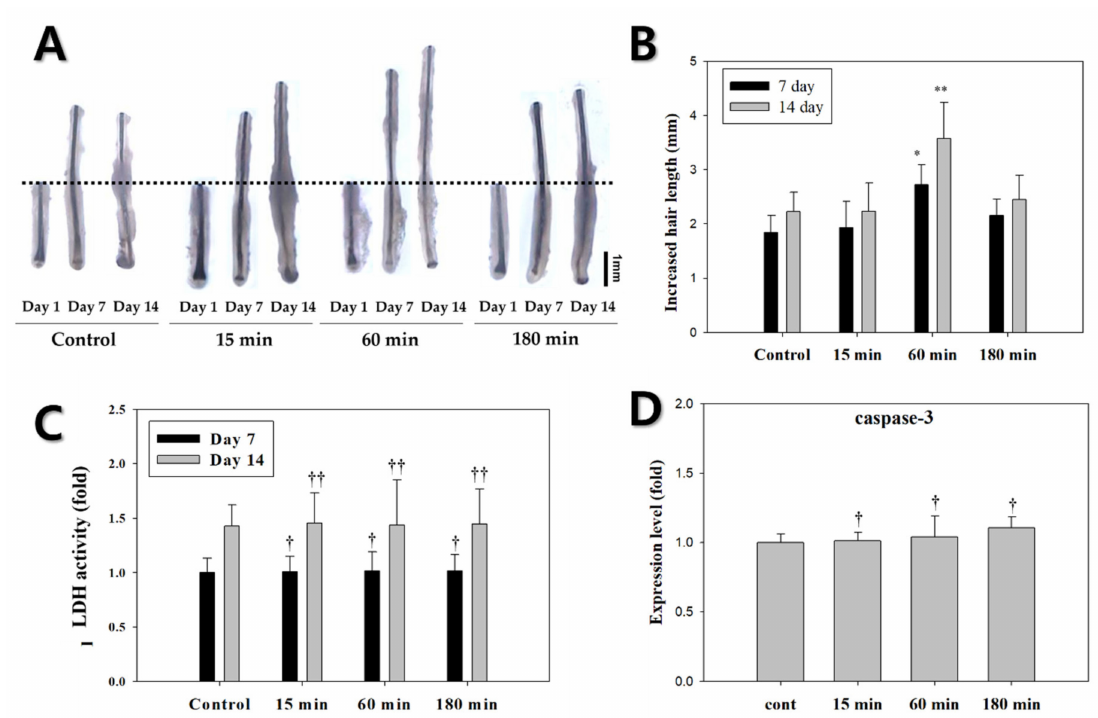
Figure 5. Effects of various ELF-EMF exposure times (15, 60, and 180 min) on human hair follicles (HFs). ( A ) Photograph of increased hair length on days 7 and 14. Original magnification: 40 × ; scale bar: 1 mm; ( B ) Increased hair length of human HFs ( n = 6, female patient samples). ( C ) Evaluation of the potential cytotoxic effect of different ELF-EMF exposure times on HFs. Cytotoxicity was measured using an LDH assay kit. ( D ) Effect of the exposure times of ELF-EMFs on HF apoptosis. Apoptosis was measured via qPCR analysis of caspase-3. Each bar represents the mean ± standard error of independent experiments performed in triplicate. Significant differences were determined via one-way ANOVA coupled with Tukey’s post hoc test (* p < 0.05, ** p < 0.01). † p , †† p > 0.5 compared to each control. The results are representative of at least six hair follicles per